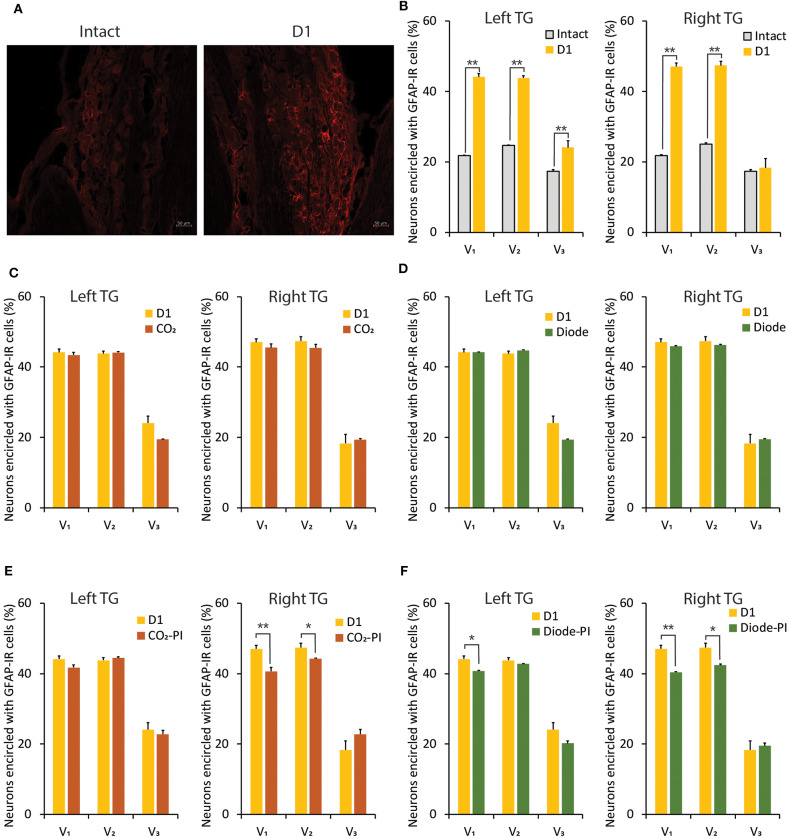
Alterations in GFAP-IR cells expression in the TG induced by orthodontic treatment and laser irradiation. (A) Immunohistochemical photomicrographs of TG neurons in the V2 branch region encircled with GFAP-IR cells in intact (left) and D1 (right) animals. Scale bar: 50 mm. (B) Comparison of the number of TG neurons encircled with GFAP-IR cells in the V1, V2, and V3 branch regions between intact and D1 animals. (C,D) Thirty seconds of CO2
(C) or diode (D) laser irradiation on D1 failed to alter the number of TG neurons encircled with GFAP-IR cells in the V1, V2, and V3 branch regions. (E,F) Thirty seconds of CO2
(E) or diode (F) laser irradiation immediately after orthodontic force application (preirradiation) significantly altered the number of TG neurons encircled with GFAP-IR cells in the V1, V2, and V3 branch regions. PI, preirradiation. Student's t-test, **p < 0.01, *p < 0.05.